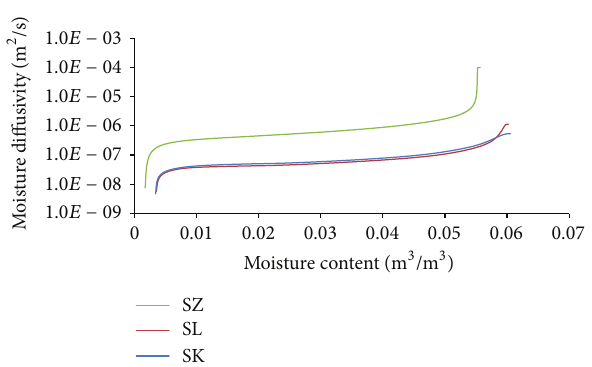
Figure 6: Moisture diffusivity versus moisture content functions.